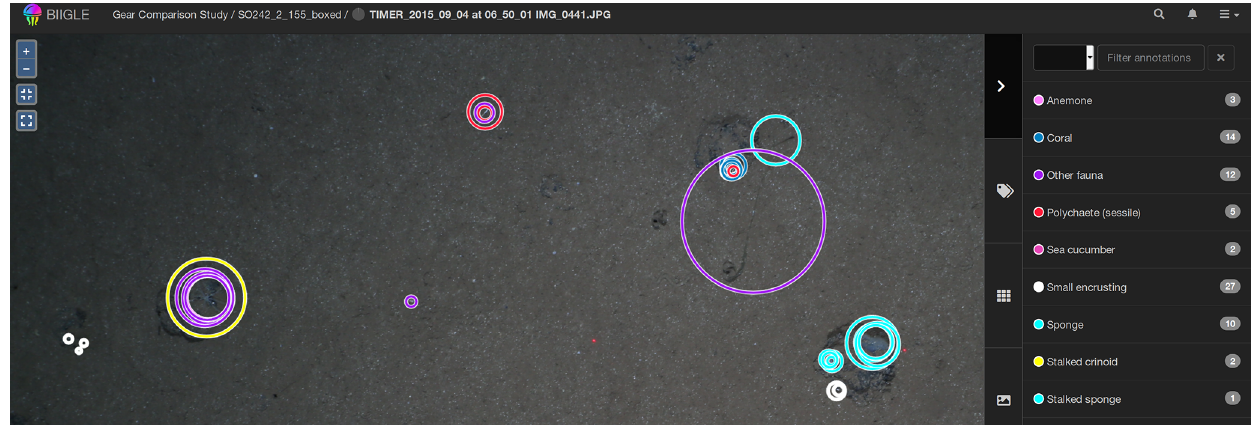
Figure 6. Circular fauna identifications made by several operators using the BIIGLE software application. Each circle corresponds to one annotation by one annotator. Colours of circles correspond to categories. Table 2. Annotation results for the eight different datasets considered in this study.